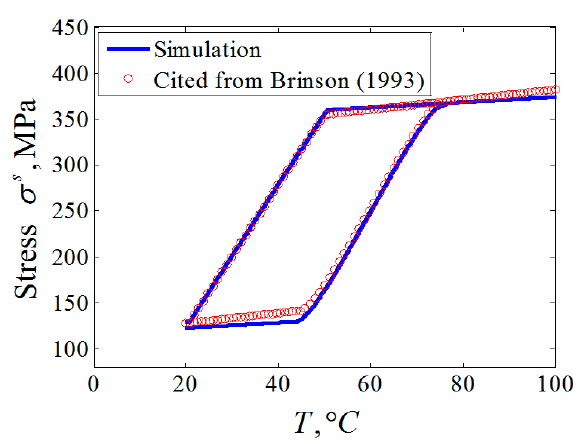
Table 1. Material parameters for the model verification [25].